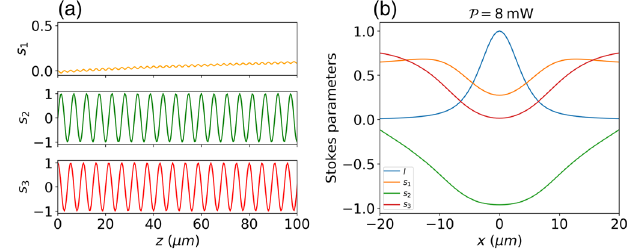
FIG. 3. Polarization structuring of Pancharatnam-Berry soli- tons. (a) Stokes parameters s 1 , s 2 , and s 3 versus the propagation distance z in the beam center x ¼ 0 . The evolution in the first 100 μ m in a 1-mm-long cell is plotted. (b) The corresponding transverse distribution of the four Stokes parameters versus x computed in z ¼ 0 . 5 mm. Here, P ¼ 8